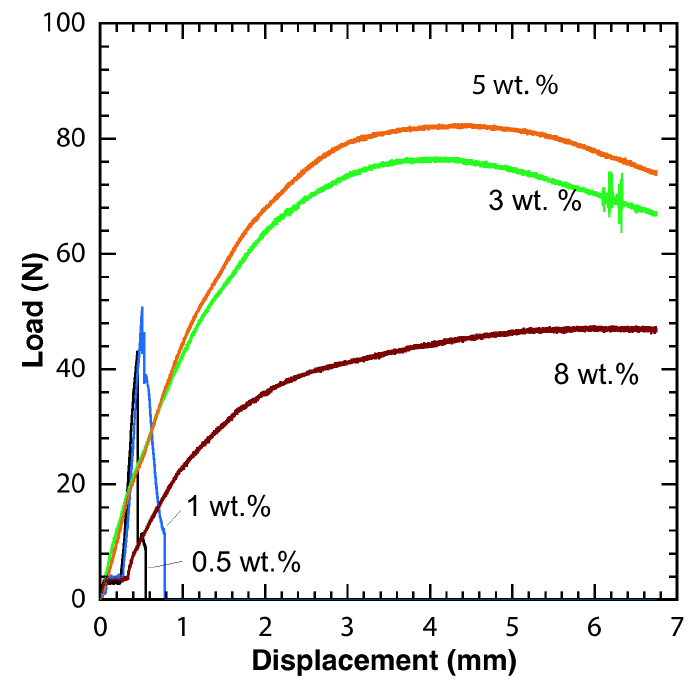
Figure 3. Load displacement curve of glycidyl POSS–epoxy nanocomposite at different POSS per- centage.